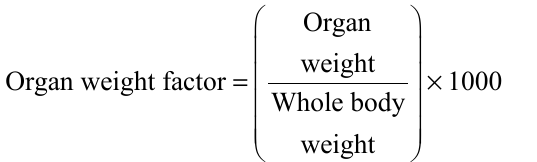
Table-2: Antibacterial activity test of CSE taking ciprofloxacin as standard drug. Component Weight of CSE/drug in each disc Zone of inhibition (mm±SE) against bacterial culture